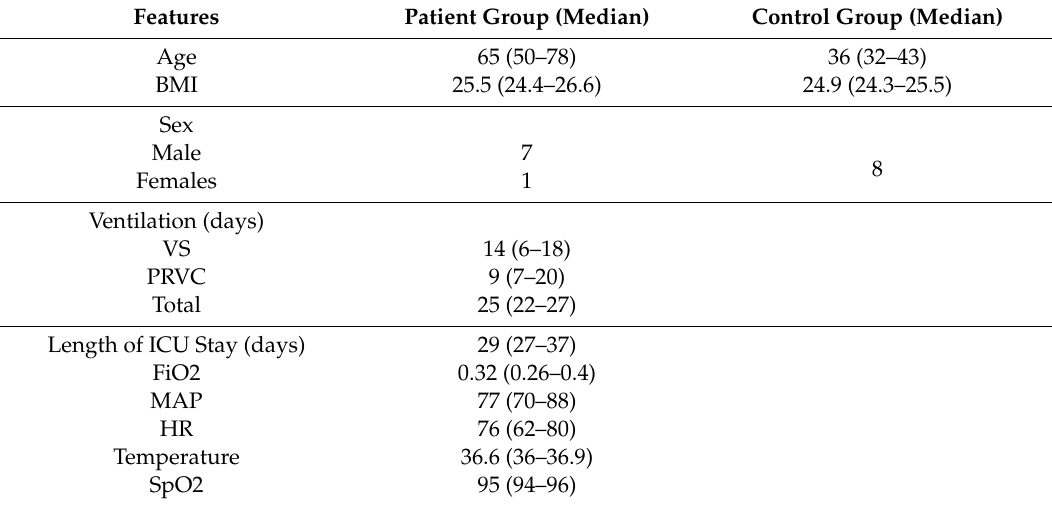
Table 1. Demographics features of Study and Control groups.